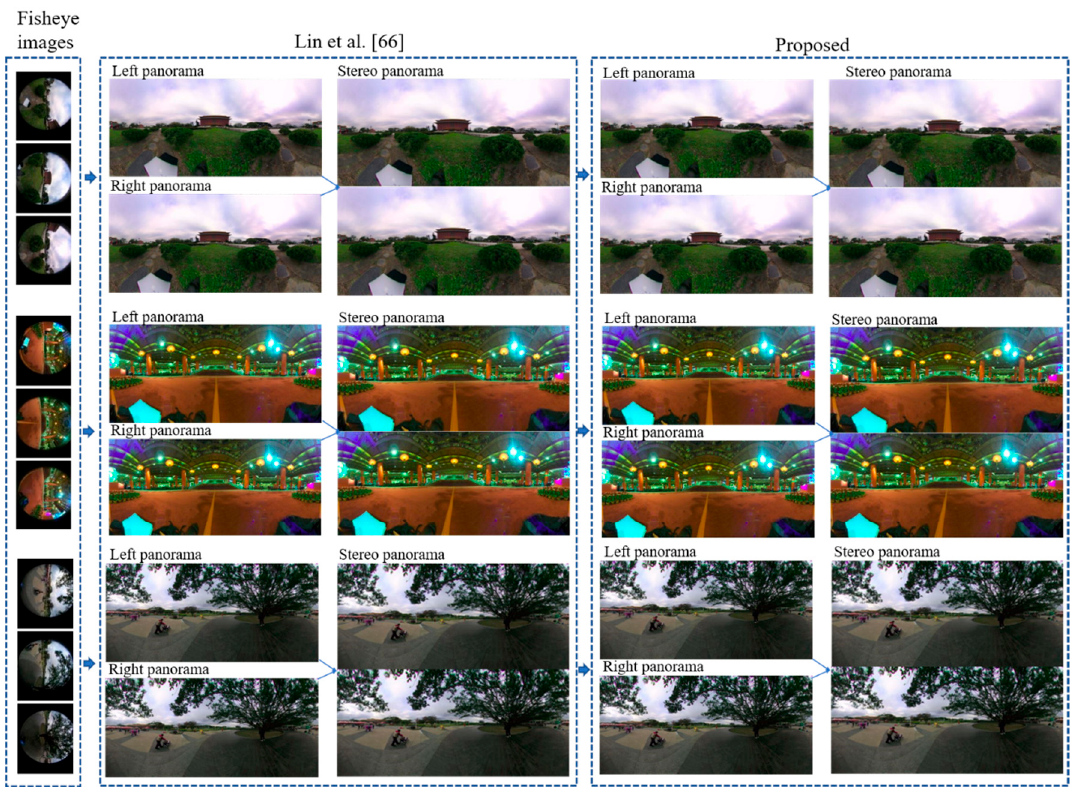
Figure 13. The visual comparison of stereo contents generated by Lin et al. [66] and our proposed system. Here, in Equation (10), the variable µ x represents the average of x, and µ y represents the average σ xy represents the covariance of x and y , c1 and c2 are the two random variables that stabilized the division with weak